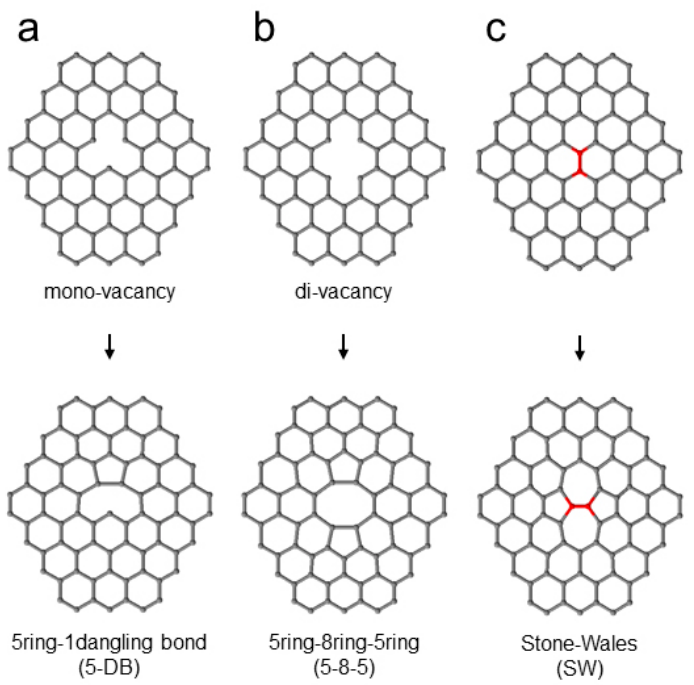
Figure 1. Schematic diagrams of non-six-membered defects. ( a ) Mono-vacancy defect changing to a combination of one five-membered ring and one dangling bond (5-1DB). ( b ) Di-vacancy defect changing to a combination of two five-membered rings and one eight-membered ring (5-8-5). ( c ) Stone–Wales (SW) defects (red parts).